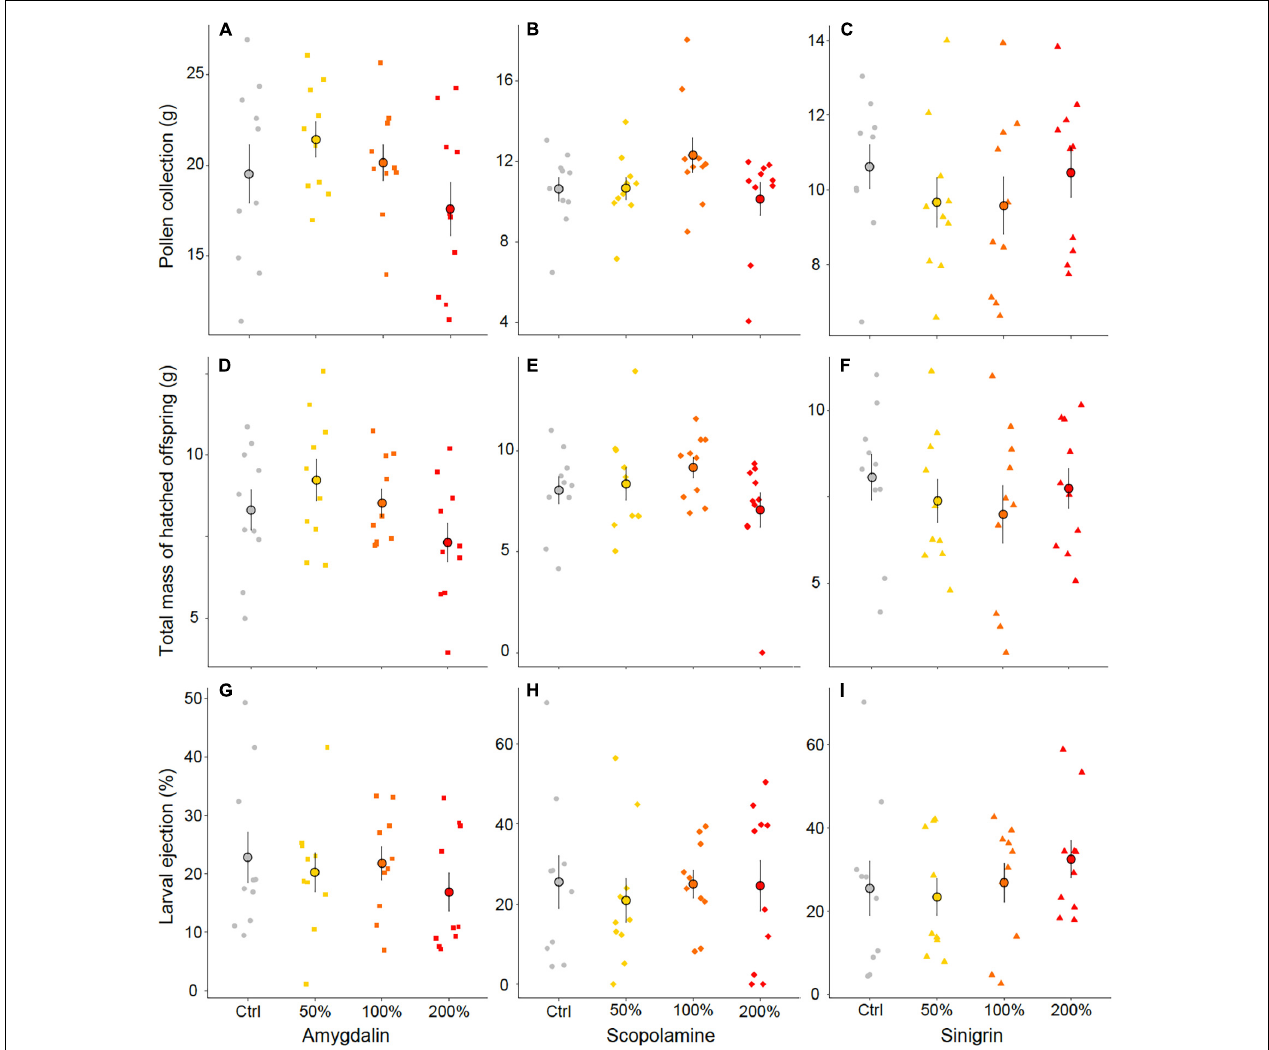
FIGURE 1 | Effects of diet treatments on resource collection, reproduction and stress response of B. terrestris in micro-colonies. (A–C) Pollen collection in each micro-colony across treatments. (D–F) Total mass of hatched offspring in each micro-colony across treatments. (G–I) Percentage of ejected larvae in each micro-colony across treatments. Each small data point represents a micro-colony and large points are mean values of each treatment. Error bars indicate the standard error of means. No significant effect was found on any